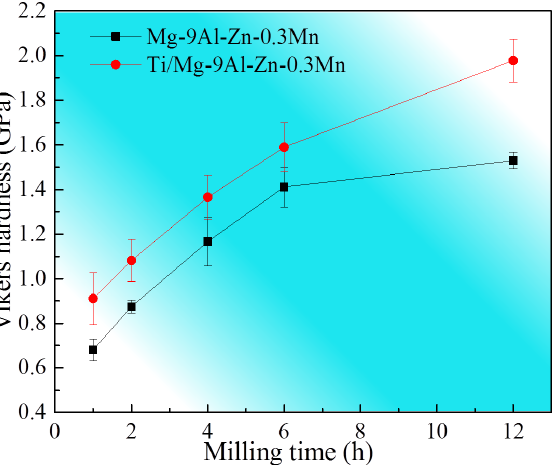
Figure 10. Hardness evolution of the milled Mg-9Al-Zn-0.3Mn alloy and Ti/Mg-9Al-Zn-0.3Mn